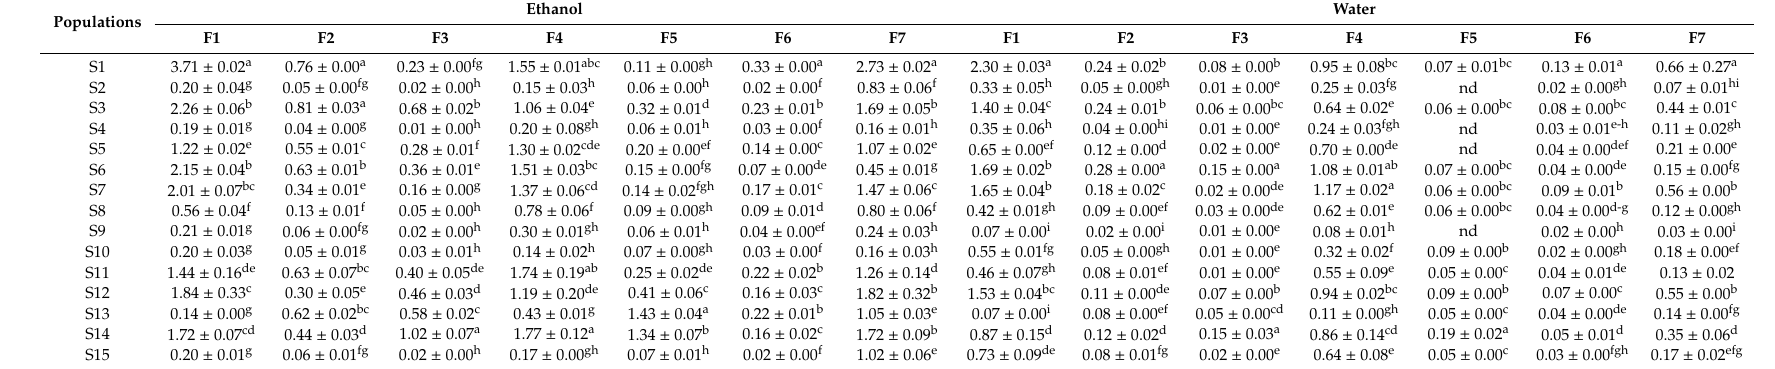
Table 2. The content (mg / g) of individual flavonoid in ethanol and water extracts of C. paliurus leaves.